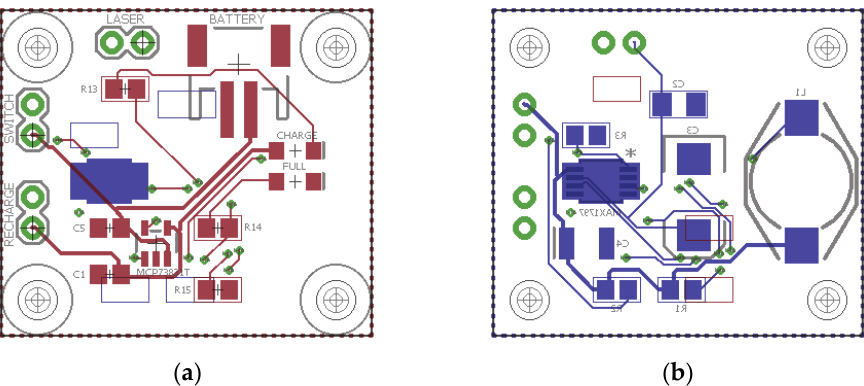
Figure 3. Front ( a ) and back ( b ) view of the PCB design for the recharge and voltage regulation board.